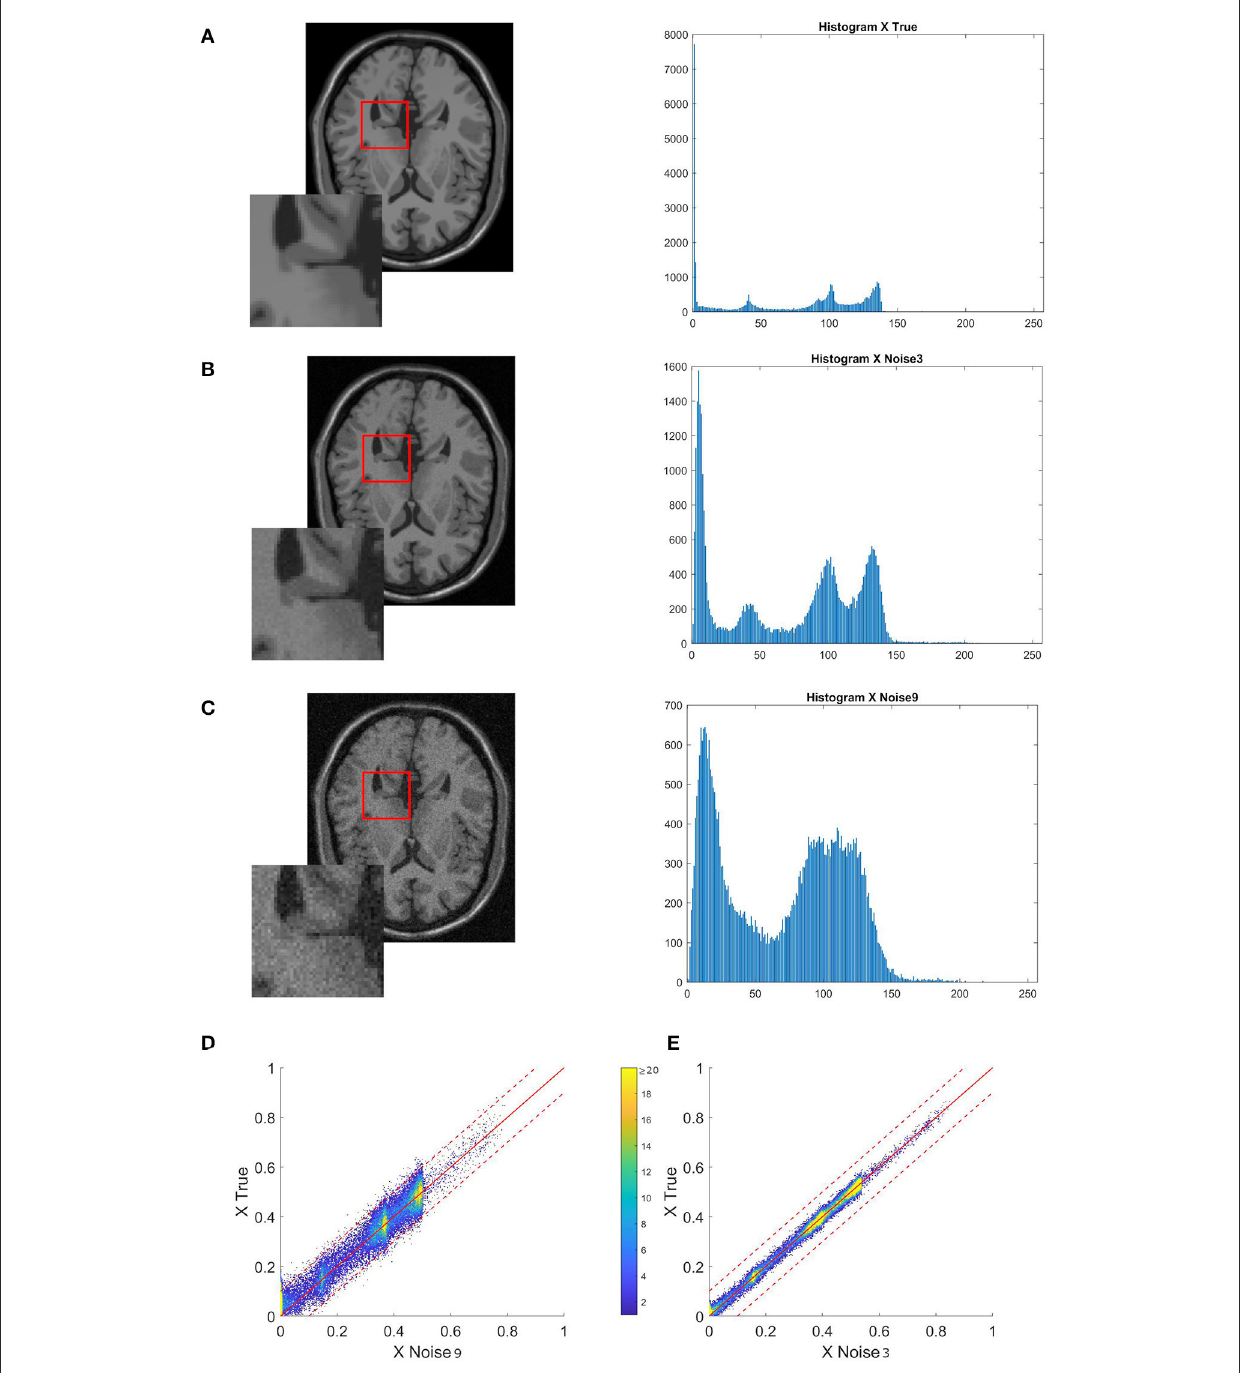
FIGURE5 Sequence of images showing their respective histograms and a merged version of their histogram in 2D. (A) Ground truth. (B) Ground truth image with 3 % noise. (C) Ground truth image with 9 % noise. (D, E) The bi-dimensional histogram of each noisy image and the true image. The clean reference image will always be on the y-axis. The histogram patterns are more similar the closer the spots are to the diagonal of the 2D histogram.